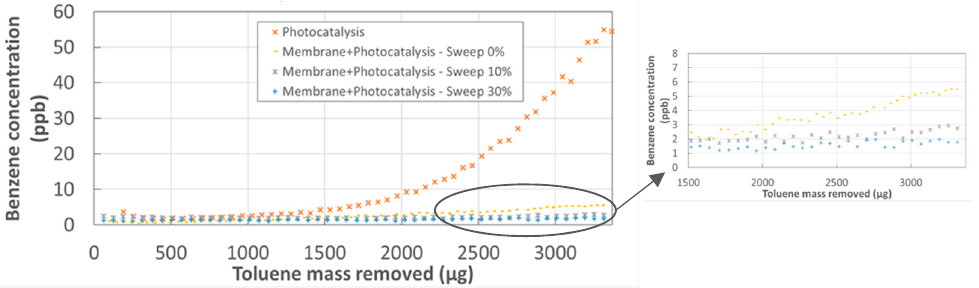
Figure 6. Evolution of benzene concentration in the retentate flow vs. toluene mass removed—catalyst m 2 − I abs = 6.9 W m − 2 .